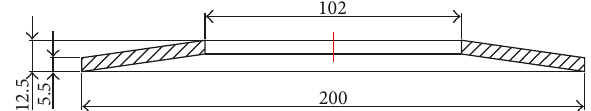
Figure 3: Monolithic disc spring